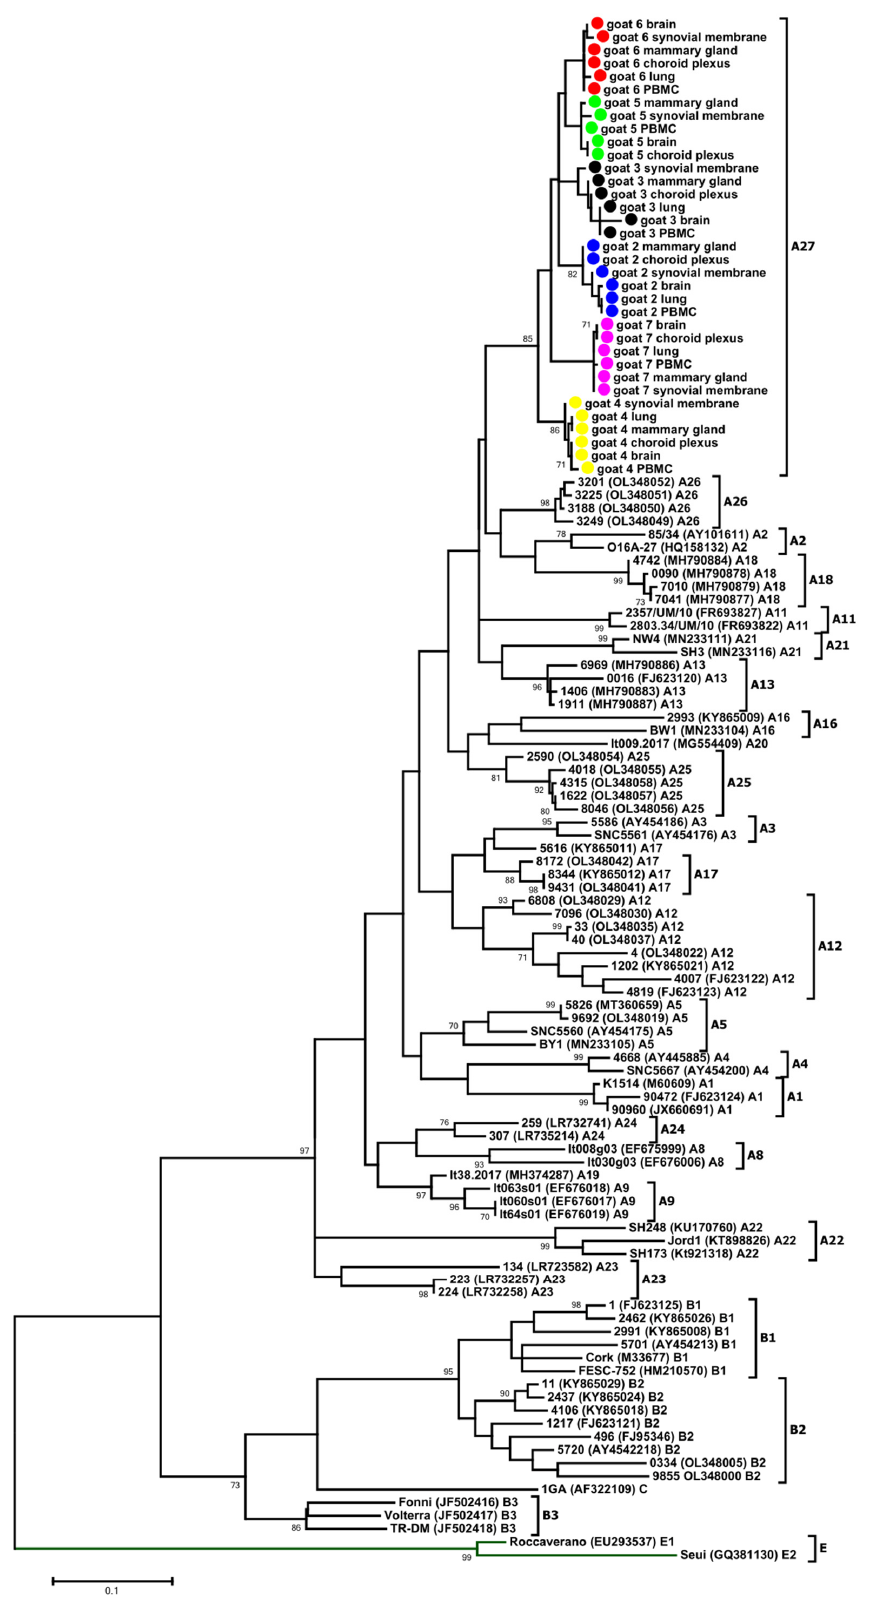
Figure 2. Maximum-likelihood phylogenetic tree based on the alignment of the CA fragment of the gag gene. Sequences from this study are labeled by black circles. Numbers at the branches indicate the percentage of bootstrap values obtained from 1000 replicates. Bootstrap values > 70% are